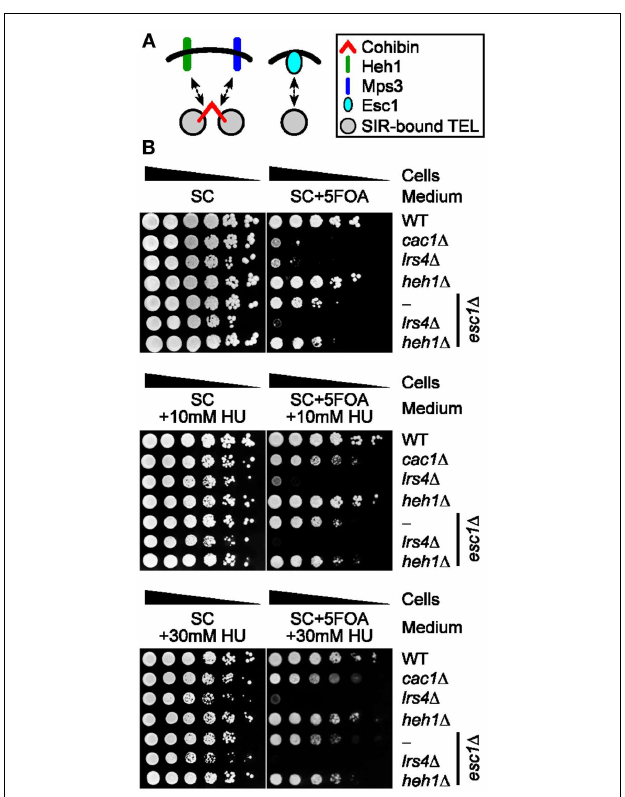
FIGURE 4 | Pharmacological inhibition of RNR function does not restore FOA-resistance in cells lacking cohibin-associated/telomere tethering nuclear envelope proteins. (A) Schematic showing relationship between cohibin and the INM proteins Heh1 and Mps3 in perinuclear telomere tethering. (B) Serial dilutions of cells with the URA3 reporter gene inserted proximal to telomereVII-L were plated on synthetic complete (SC) medium or medium supplemented with a sublethal concentration of hydroxyurea ( + HU) and/or 5FOA ( + 5FOA).WT, wild-type. Strains: KMY368, KMY1465, KMY74, KMY59, KMY999, KMY1468, KMY1470. (C) Deletion of LRS4 or HEH1 does not affect mps3 ∆ 75-150 levels as indicated by immunoblotting. A non-specific band served as loading control. All lanes were run and transferred from the same gel.WT, wild-type. Strains: KMY368, KMY999, KMY1467, KMY1468, KMY1469, KMY1470.